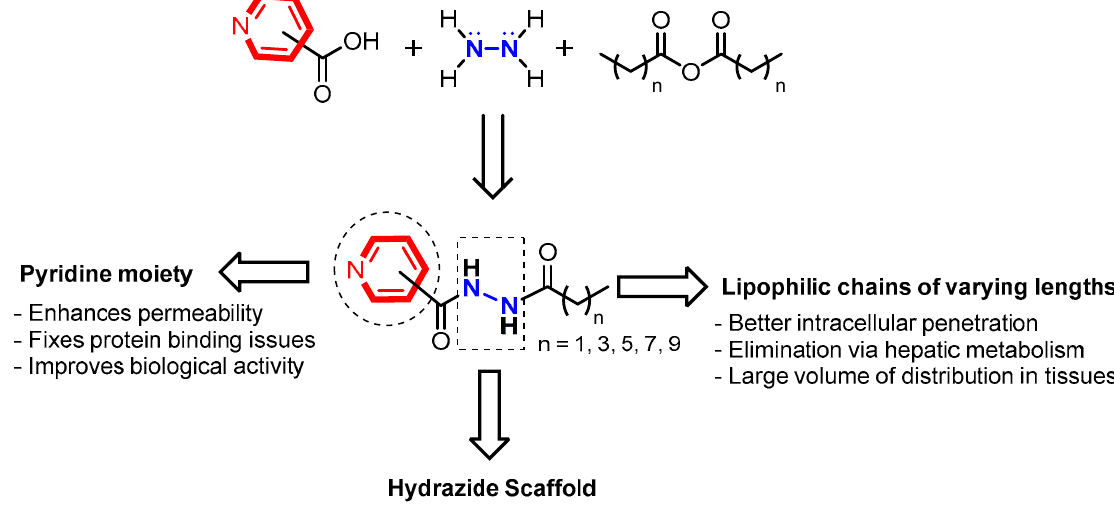
Figure 6. Design rationale for pyridine carbohydrazides with lipophilicity modulation.